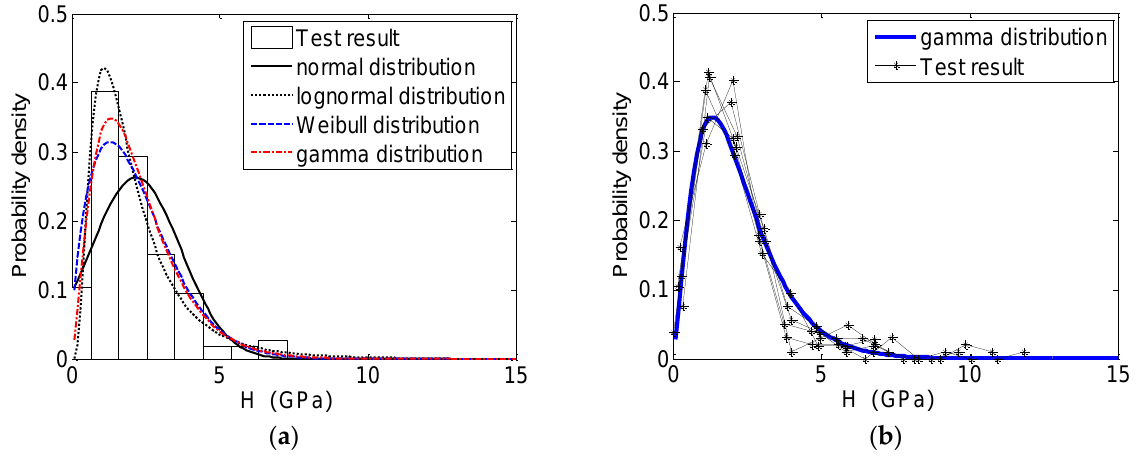
Figure 6. Frequency plots for indentation hardness of the ITZ: ( a ) histogram of one point out of six and 4 theoretical PDF curves; ( b ) frequency plots of 6 points and the theoretical PDF curve with best estimates.